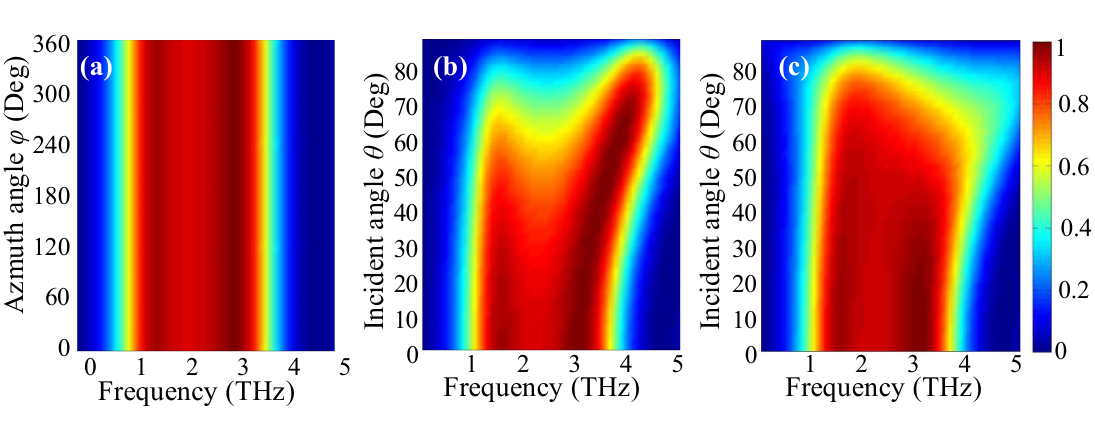
Figure 6. The simulated absorption spectra of the proposed absorber as functions of frequency and the terahertz wave polarization angle φ ( a ), as well as the frequency and the oblique incident angle θ for both TE polarization ( b ) and TM polarization ( c ).